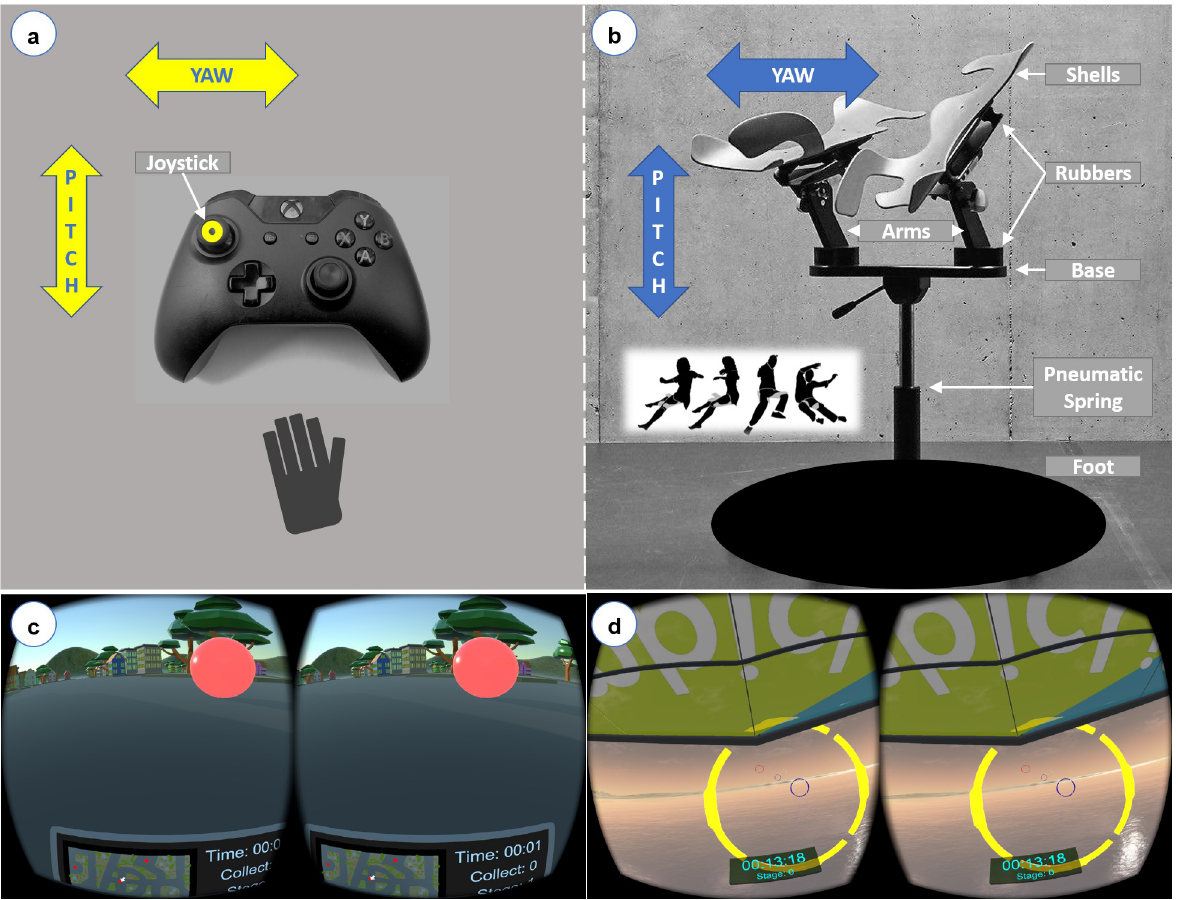
Fig 1. Two control interfaces (a,b) and two VR experiments (c,d). (a) The gamepad is a conventional device with which pitch and yaw movements can be controlled by hand. (b) On the Limbic Chair, the pitch and yaw of users’ legs are translated into movements through the virtual environment. Images of (c) the city navigation scenario and (d) the flight simulation scenario as displayed in the Oculus Rift [8].